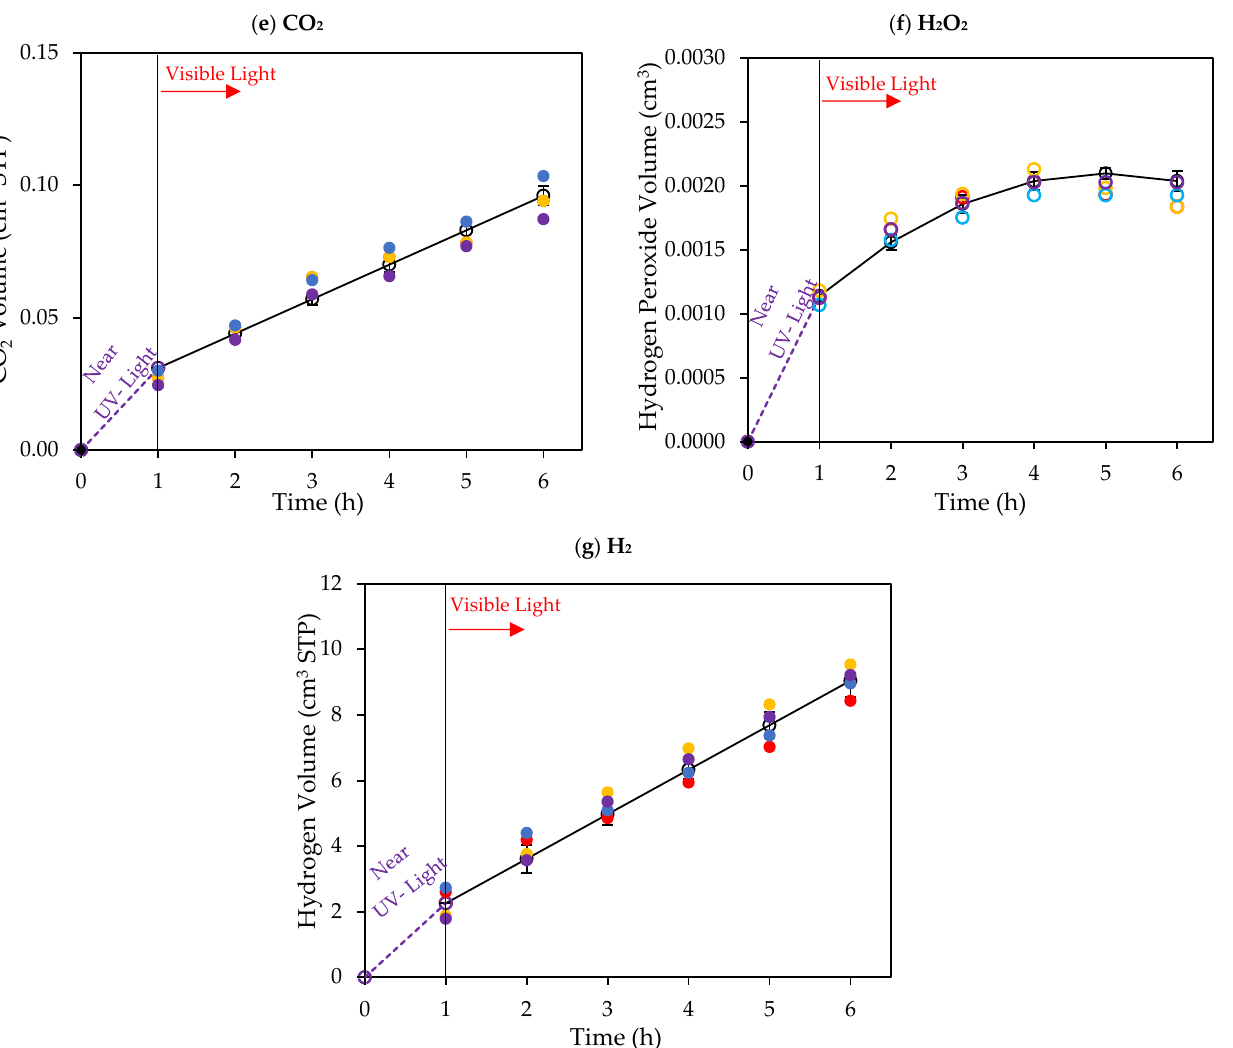
Figure 10. Cumulative chemical species volumes obtained under 1 h of near-UV followed by 5 h of visible light near-UV: ( a ) methane; ( b ) ethane; ( c ) ethylene; ( d ) acetaldehyde; ( e ) CO 2 ; ( f ) H 2 O 2 ; and ( g ) H 2 . Experimental data are represented by ( ○ ) filled with different colors, each color represents each experimental run, and model predictions are represented with solid lines. Experimental conditions: 0.25 wt% Pd-TiO 2 ; 0.15 g L − 1 photocatalyst concentration; initial pH = 4.0 ± 0.05; and 2.0 v / v % ethanol. Table 4 reports the seven determined intrinsic kinetic constants along with their small standard deviations and 95% confidence intervals. The k 1′ constant was set to 3.45 × 10 − 4 mol g cat −1 h −1 , while the k 5′ constant for the pH increase was set to 9.11 × 10 − 2 h −1 . Table 4. Intrinsic Kinetic Rate Constants for Hydrogen Production and By-Product Formation under Visible Light, with 2.0 v / v % Ethanol. Photocatalyst was photoreduced for 1 h under near-UV. The 𝑄 𝐸𝑡𝑂𝐻,𝑚𝑎𝑥 adsorption constant was set to 0.315 mol g cat −1 , as shown in Section 3.3. Intrinsic Kinetic Rate Constant (mol g cat − 1 h − 1 )